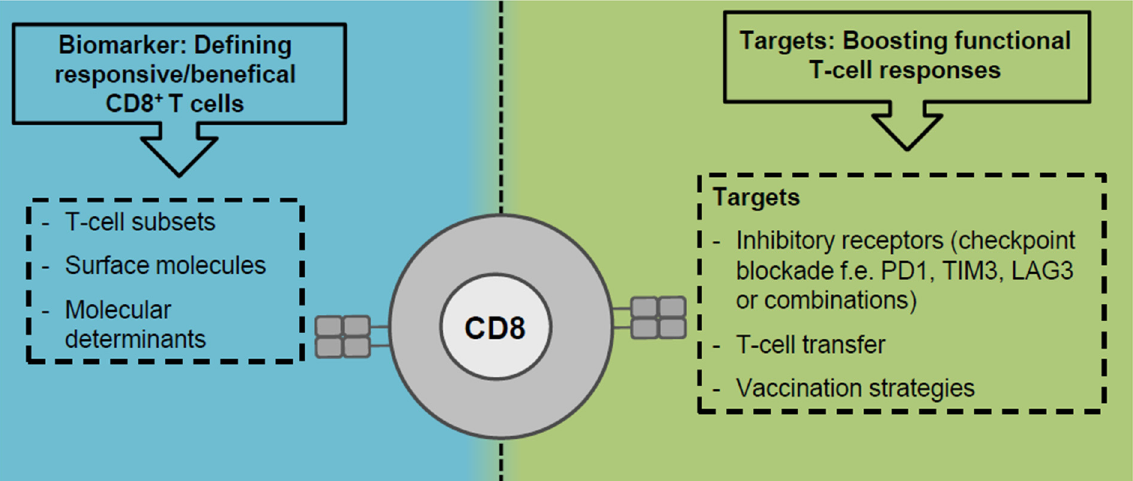
Figure 2. Perspectives of CD8 + T cells in immunotherapeutic approaches. CD8 + T cells may have potential roles as targets and biomarkers in immunotherapy.